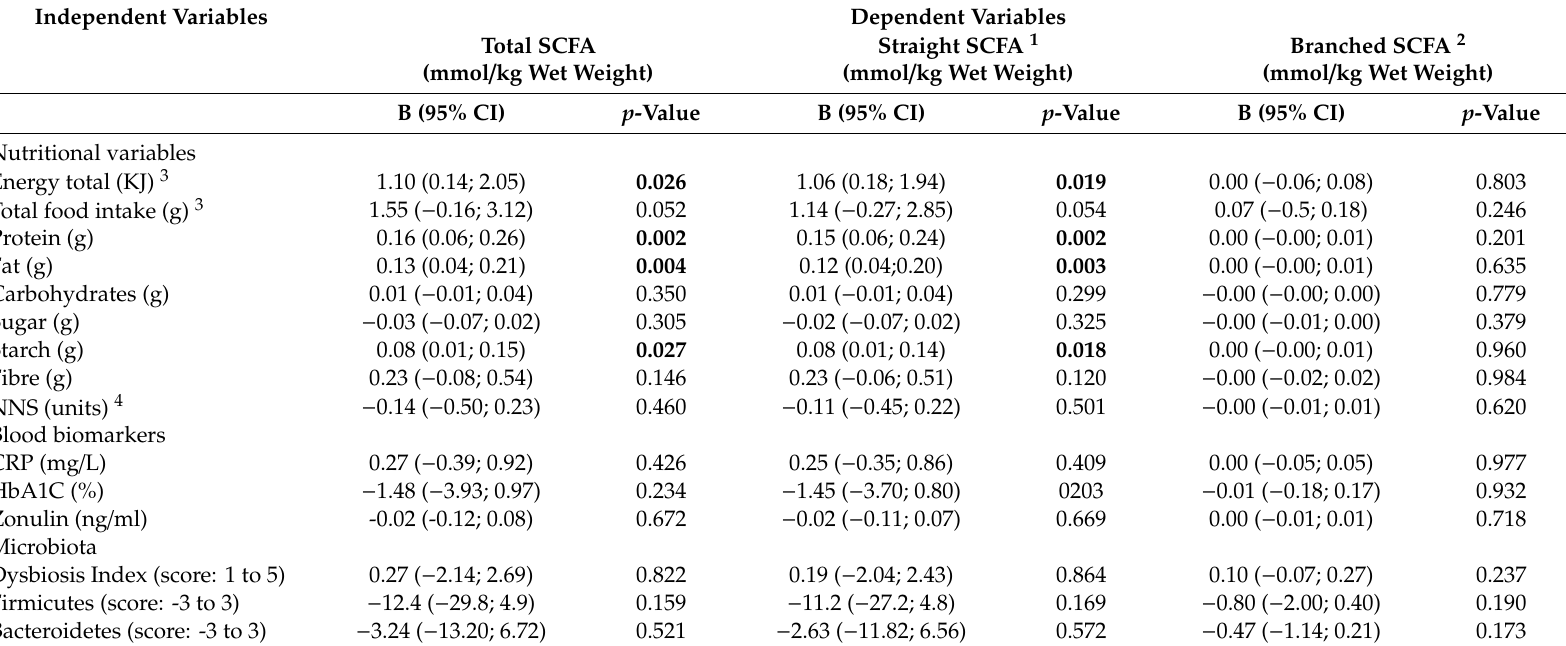
Table 3. Associations between the SCFA levels and the nutrients, biological markers and the microbiota composition markers analyzed with mixed model adjusted for the point of time and the mean of age and